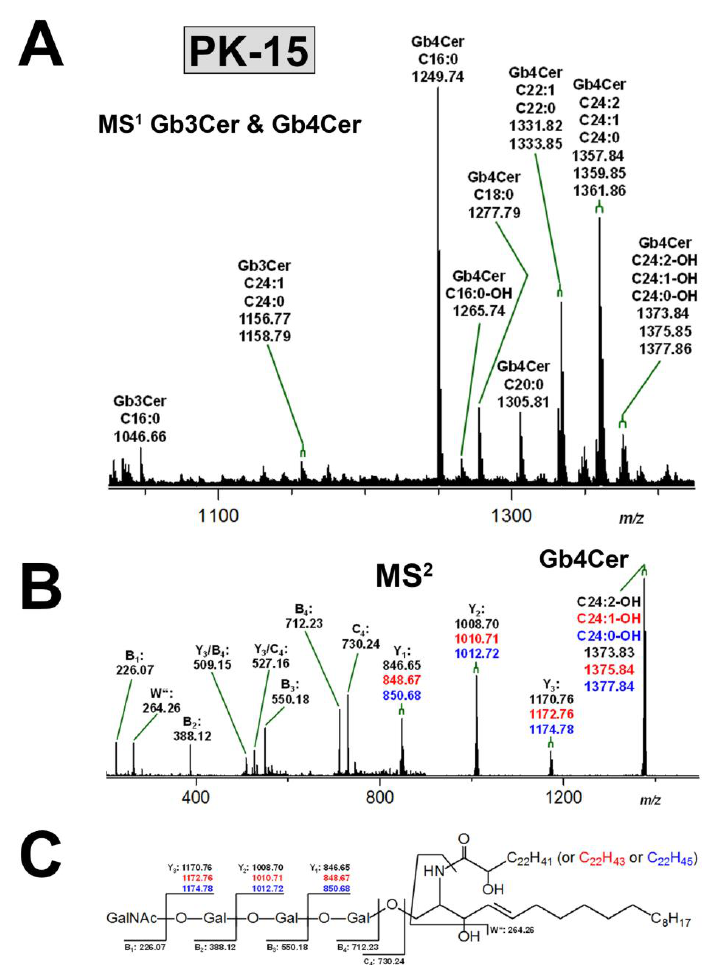
Figure 4. Overview MS 1 spectrum of the Stx receptor GSLs Gb3Cer and Gb4Cer ( A ) and MS 2 spectrum of the selected Gb4Cer triplet composed of Gb4Cer lipoforms harboring Cer (d18:1, C24:2-OH), Cer (d18:1, C24:1-OH), and Cer (d18:1, C24:0-OH), respectively, ( B ) with the auxiliary fragmentation